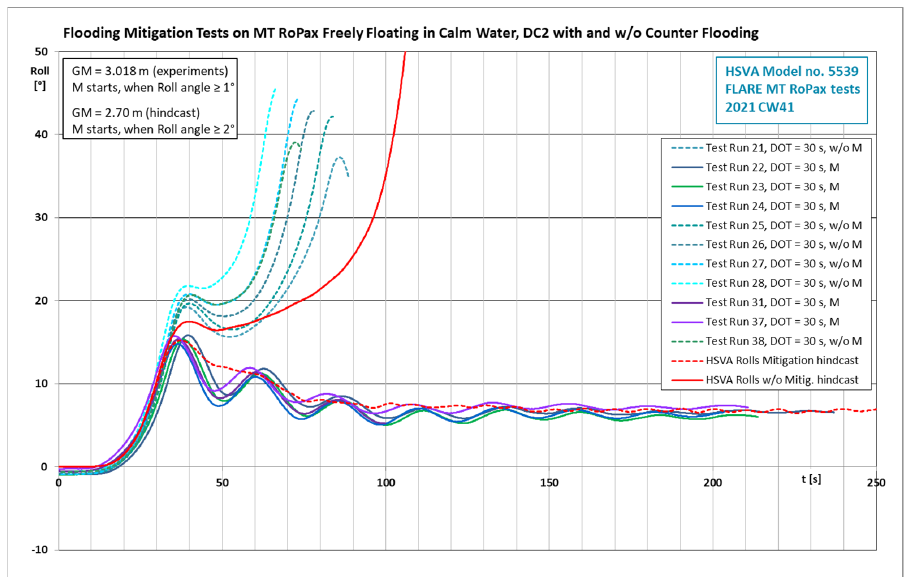
Figure 10. Damage Case 2 with damage opening time 30 s: Roll angle as a function of time with (solid lines) and without (dashed lines) counter flooding in model tests. The red solid line shows the numerical hindcast without mitigation, the dashed red line with mitigation.